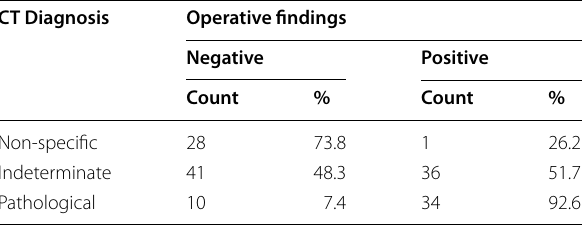
Table 6 Correlation between the lymph node diagnosis by ultrasound and final pathology Ultrasound Diagnosis